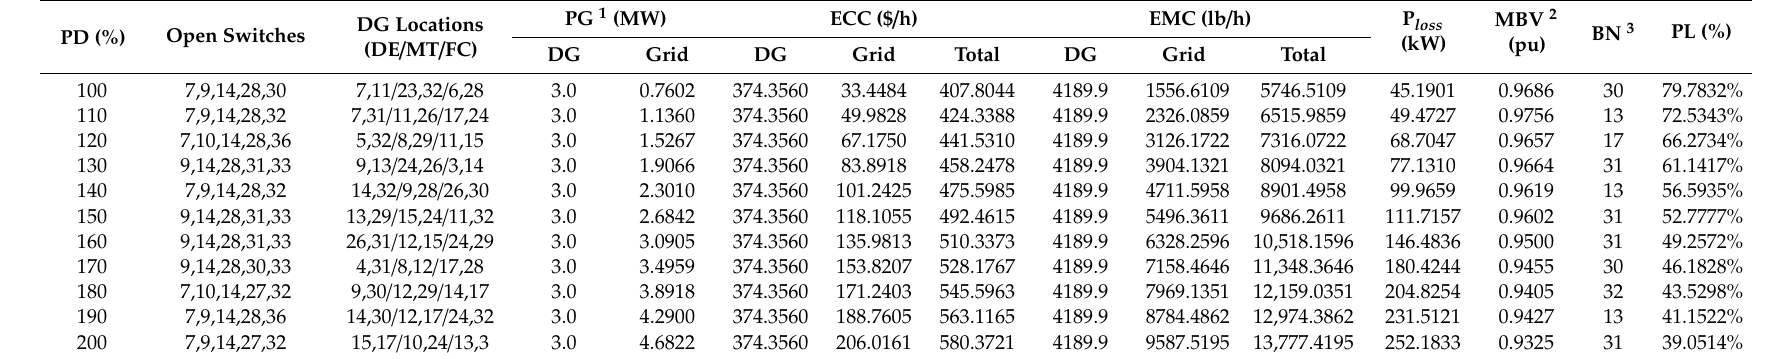
Table 11. Scenario 1: system reconfiguration results of DG combinations under 6 DGs and increasing power